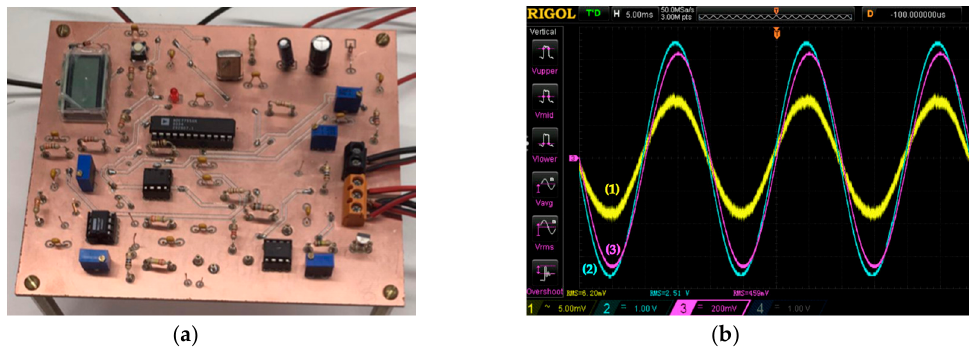
Figure 12. ( a ) Prototype energy meter implementation; ( b ) Experimental waveforms: (1) TMR sensor output voltage (6.2 mV rms ); (2) Conditioned output voltage (2.51 V rms ); (3) Electrical current through resistive load (4.59 A rms and P load = 1000 W).